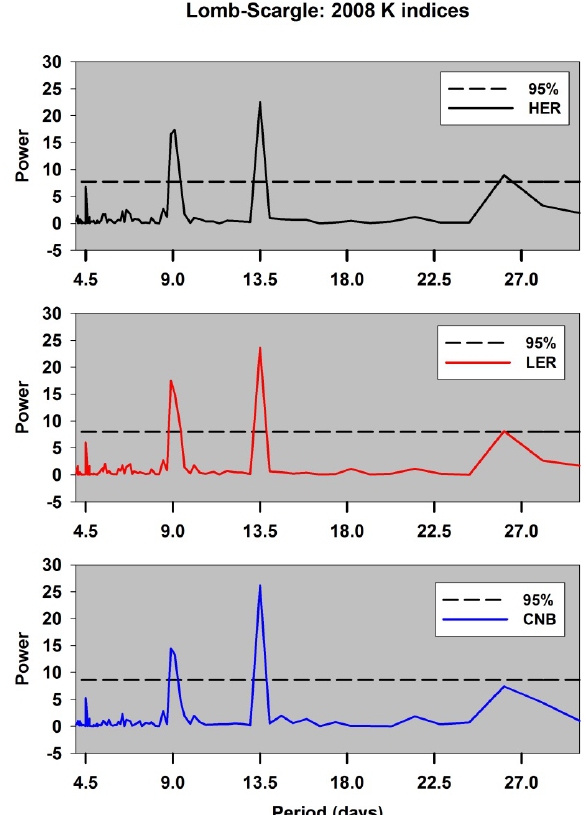
Figure 6. A Lomb–Scargle analysis of the periodicity at HER, LER and CNB during 2008 showing the dominance of the 9.0- and 13.5- day periods above the 95% confidence